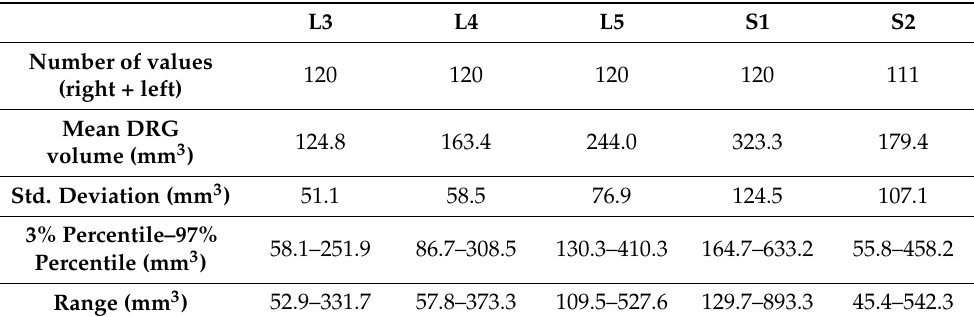
Figure 3. Box-and-whisker plot of dorsal root ganglia (DRG) volumes as assessed by exact volumetry after 3D-segmentation in 60 healthy individuals. Median values are indicated by the horizontal line. Box length shows interquartile range, whereas whiskers represent range of data. NS = non-significant. Normal values of DRG volumes were assessed by exact volumetry in all 60 participants (Table 1). Since we did not find any difference between right and left DRG, normal values are reported based on an analysis of both sides. DRG S2 was not included in the field of view (FOV) in four cases (right hand side) and five cases (left hand side). All other DRGs could be assessed. Table 1. Normal values of dorsal root ganglia (DRG) volume as assessed by exact volumetry after 3D-segmentation in 60 healthy